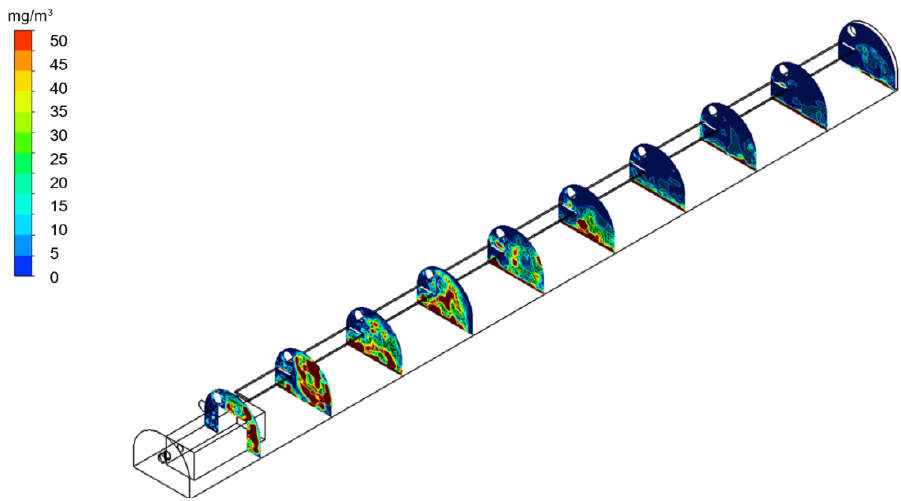
Figure 6. Distribution of different-sized dust particles in the dog heading at various times for total dust rate = 0.00075 kg/s.